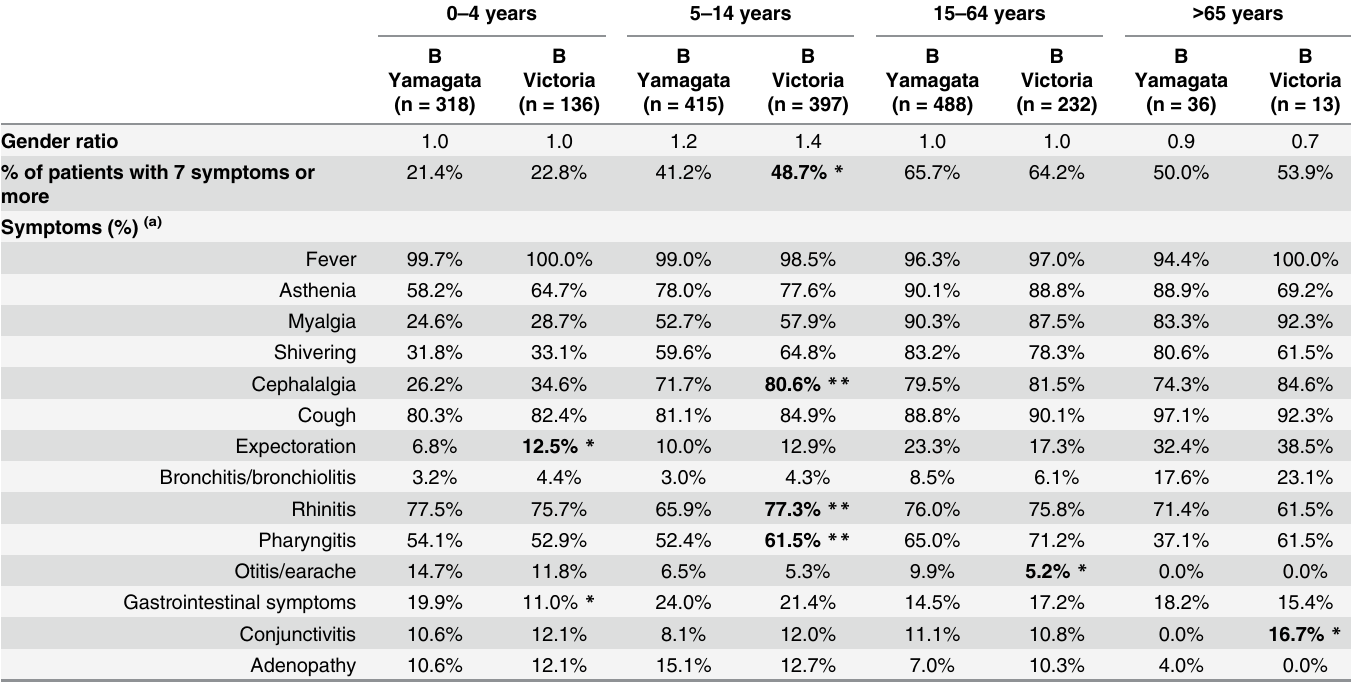
Table 4. Clinical Presentation of Influenza B Patients According to Age Group and Virus Lineage (Victoria versus Yamagata). The IBVD (Influenza B in Vircases database) Study, France, 2003 – 2004 to 2012 –